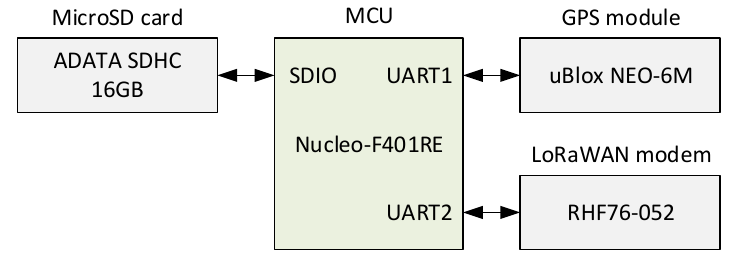
Figure 9. Block diagram of the end-device used for